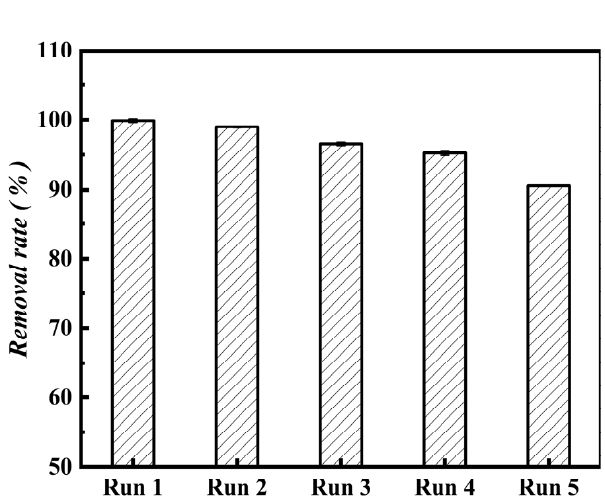
Figure 12. The influence of cycle times on adsorption.